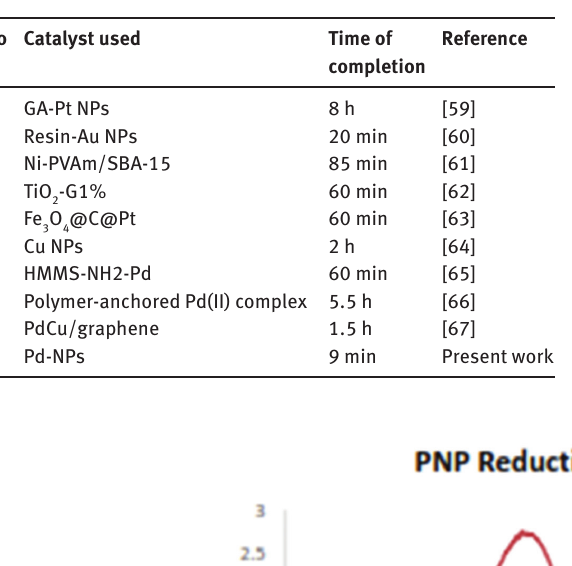
Figure 13 showed linear correlation between ln (Ao/At) verse time in minutes and the rate constant “K” for this reaction was found to be 0.049 min −1 for PdNPs stabilized by guar gum. Table 2: Comparison of the results of this work with other reported methods in the reduction of 4-NP to